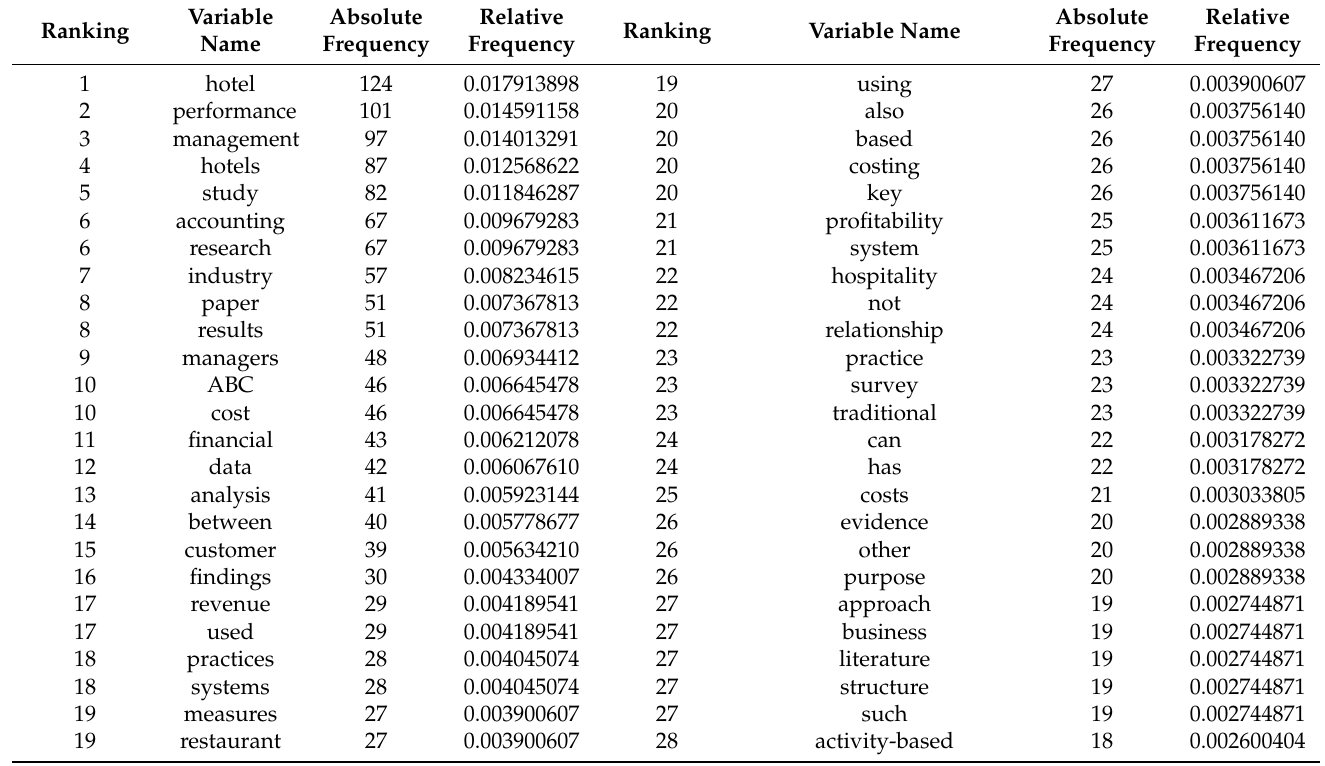
Table 2. Top 50 of most frequent words in